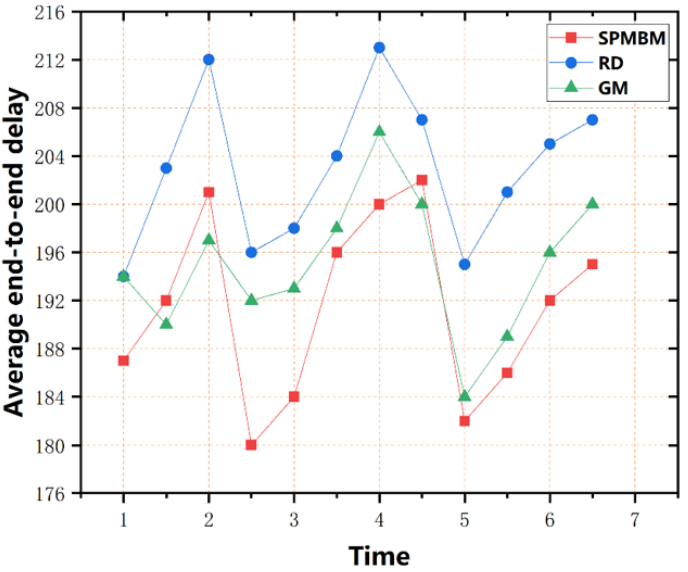
Figure 10. Relationship between average end-to-end delay and time in three mobility models.